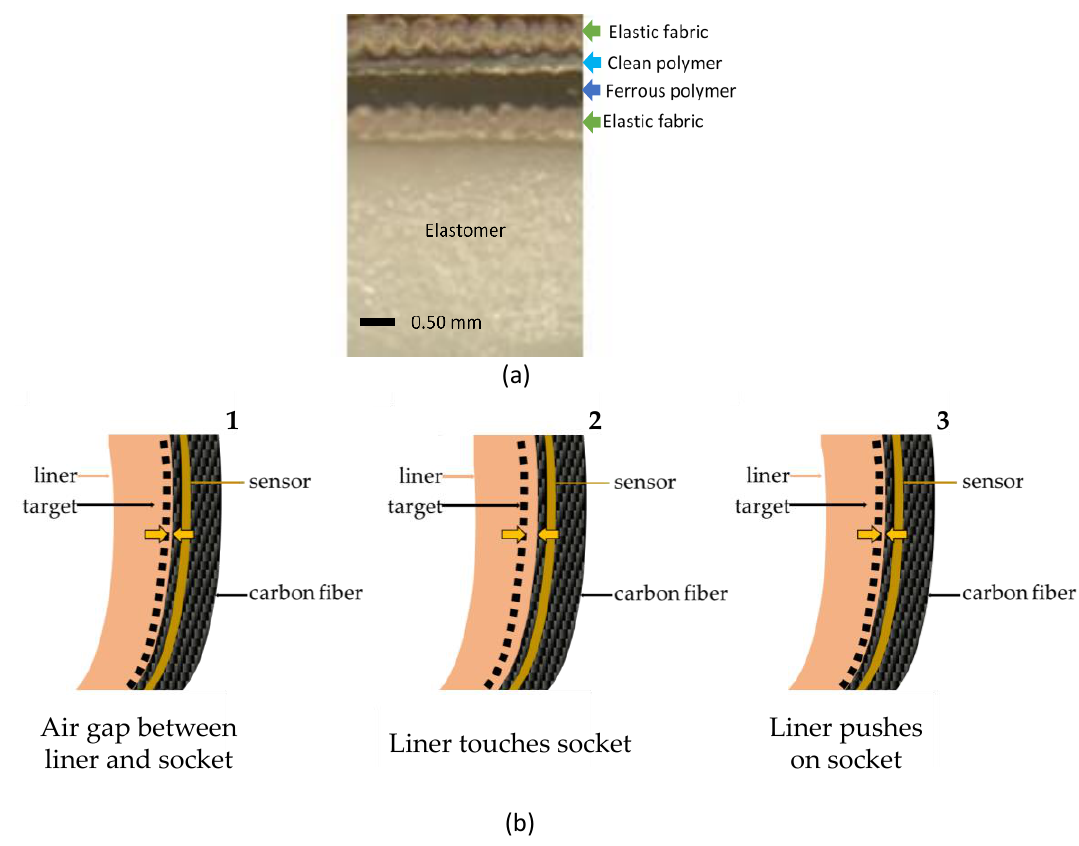
Figure 1. Ferrous liner. ( a ) Cross-section of a ferrous liner immediately after fabrication. ( b ) Three possible configurations of measurement. Orange arrows indicate distance between the target and socket.